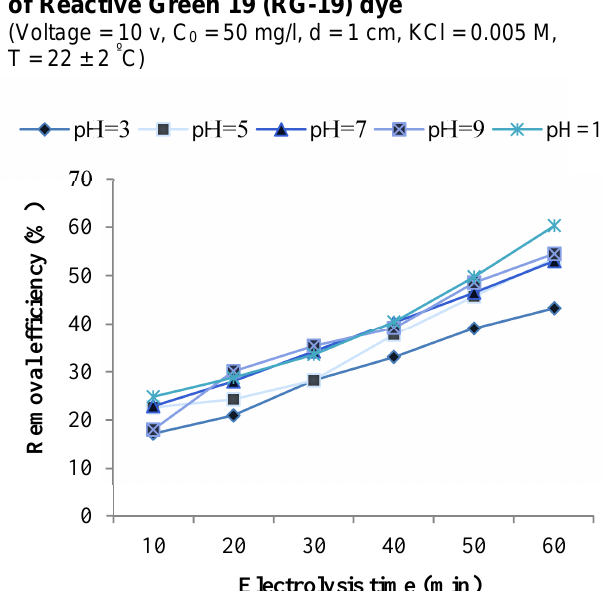
Figure 3. Effect of initial pH on removal efficiency of Reactive Green 19 (RG-19) dye (Voltage = 20 v, C 0 = 50 mg/l, d = 1 cm, KCl = 0.005 M, T = 22 ± 2 º C)